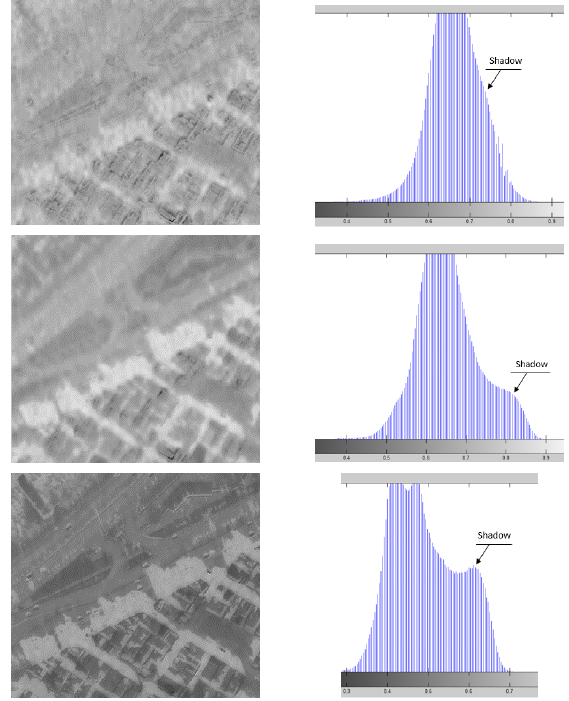
Figure 4. C3 (top), blue/near infrared ratio (middle) and C3new (bottom) indices and following histograms After calculating index values for the image pixels, Otsu thresholding algorithm is employed to automatically find the best threshold to detect shadow pixels. Morphological erosion filter the result to increase reliability of detected shadow pixels.